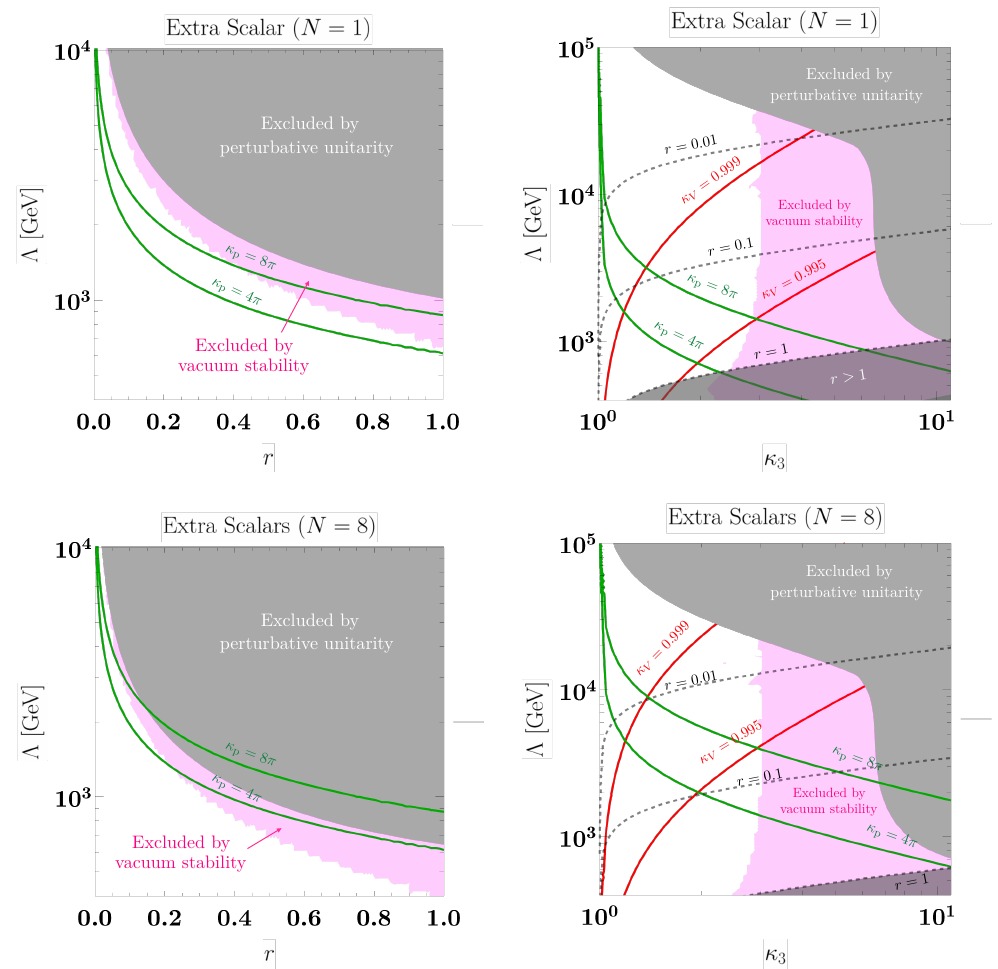
Figure 6 . Perturbative unitarity bound (Gray) and vacuum stability bound (Magenta) for the case discussed in section 2.1. We take N = 1 (Top) and 8